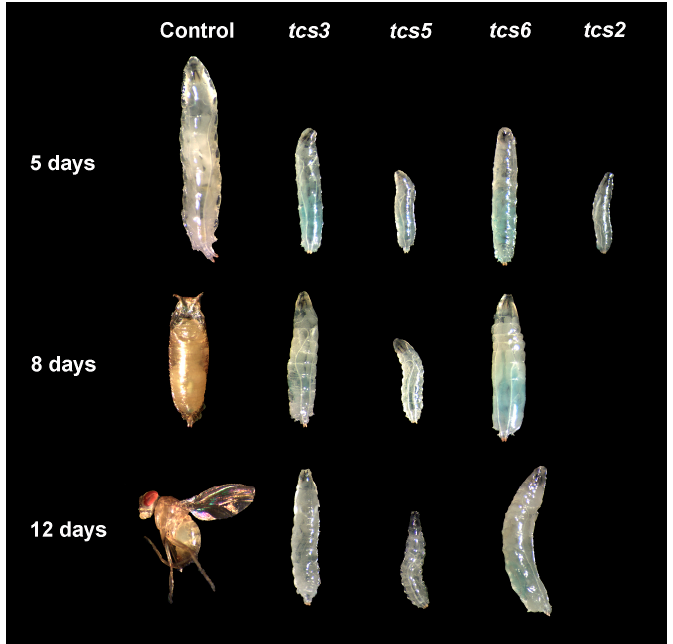
Figure 2. Ubiquitous knockdown of t 6 A modification system results in reduced larval size. Ubiquitous knock down of components of the threonyl ‐ carbamoyl transferase complex (TCTC) and tcs2 was achieved